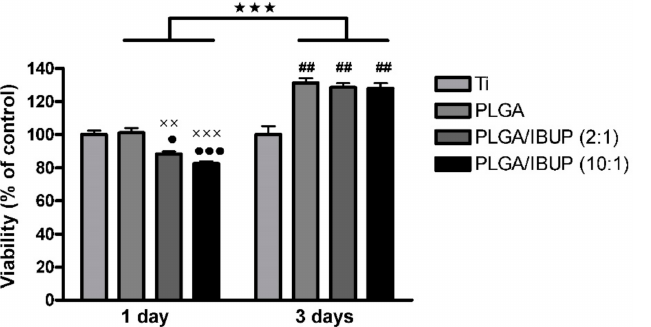
Figure 7. Viability of human macrophages grown in contact with PLGA-based coatings for 1 and 3 (cid:70)(cid:70)(cid:70) p days (MTS assay); < 0.001 vs. 1-day time point; ••• p < 0.001, • p < 0.05 vs. Ti; ××× p < 0.001, ×× p < 0.01 vs. PLGA; ## p < 0.01 vs. Ti.